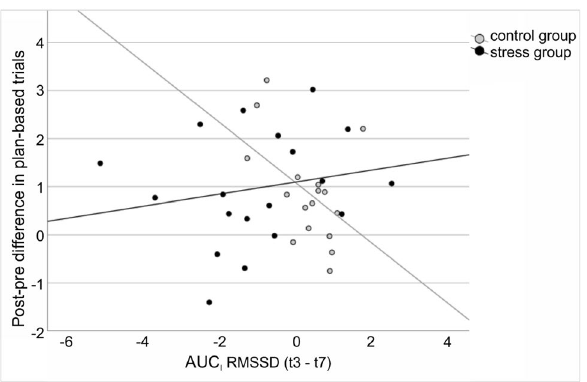
Figure 4. Interaction of AUC I RMSSD (t3–t7) and group (stress versus control) predicting the post–pre difference in plan-based trials. Lines reflect the linear regression lines per group. Grey dots represent participants from the control group and black dots represent participants from the stress